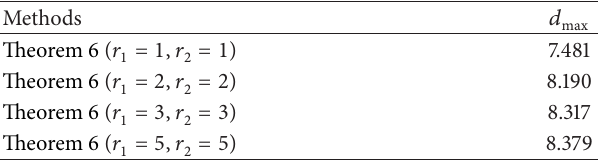
Table 1: The upper bound of 𝑑 max for ℎ = 1 and 𝛾 = 0.2 .